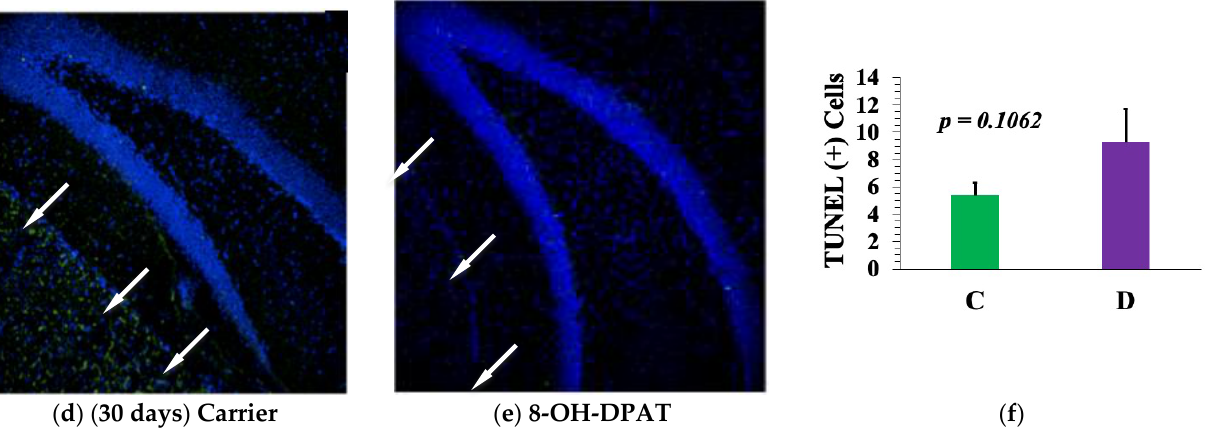
Figure 6. TUNEL assays reveal that 8-OH-DPAT treatment in vivo does not block apoptosis in the DG. TUNEL (+) cells were marked green within the HOECHST33342-stained dentate gyrus granule cells. TUNEL assays were performed with nine sections per brain from four mouse pups per treatment ( n = 4). The groups of mice were treated with ( a ) carrier (vehicle) or 8-OH-DPAT (D) for 24 h (to analyze apoptosis during neuroproliferation) or ( b ) 30 days (to analyze apoptosis during neurogenesis). ( c , f ) Neither experiment recorded a significant decrease in TUNEL (+) cells in the DG. ( c , f ) A large number of TUNEL (+) apoptotic cells were observed in the subventricular zone (SVZ) (white arrows) of the carrier (vehicle)-treated but not in the 8-OH-DPAT-treated mice ( d , e ). Student’s t -test was used for data analysis. Scale bar: 47.62 µm.